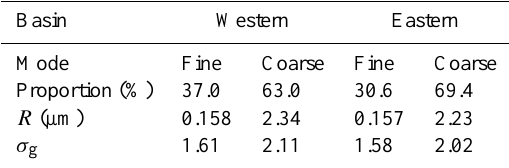
Table 3. Adjusted parameters of particle volume size distributions averaged for the stations relevant to the western and eastern basins (see Fig. 9), assuming bimodal lognormal distributions ( R is the modal radius and σ g the geometric standard deviation). Basin Western Eastern Mode Fine Coarse Fine Coarse Proportion